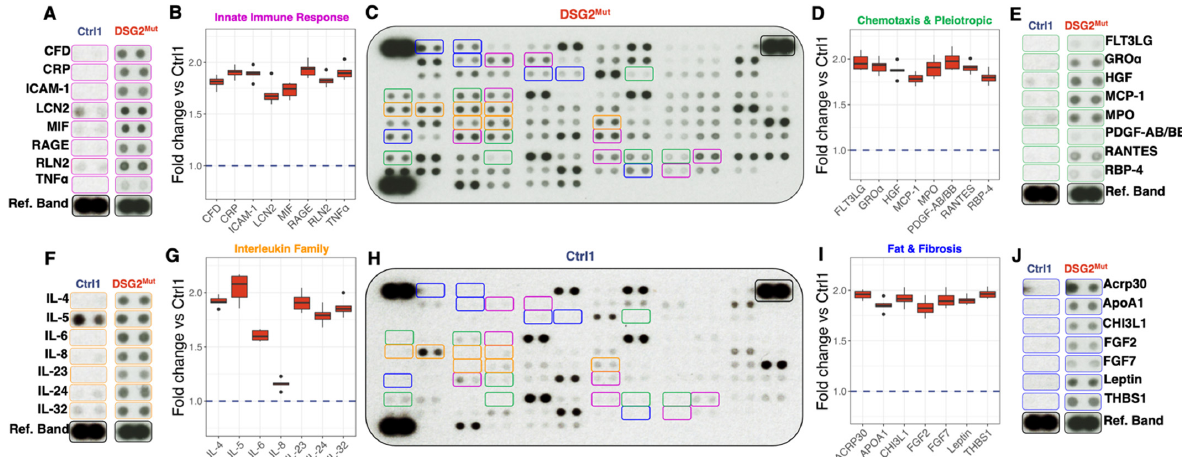
Figure 4. Cytokine expression in DSG2 Mut hiPSC-CMs. ( A , C , E , F , H , J ) Representative cytokine immunoblots from wildtype control (Ctrl1) and DSG2 Mut hiPSC-CMs, grouped based on their role in inflammation: ( A ) the innate immune response (purple); ( E ) chemoattractant and pleiotropic regulation (green); ( F ) interleukins that regulate immune cell differentiation and proliferation (orange); and ( J ) adipo-fibrokines involved in lipid accumulation and metabolism and fibrotic remodeling (blue). ( B,D,G,I ) Box and whisker plots of selected cytokines from Figure 4A,E,F, and J. Data presented as mean ± standard deviation.; Blue dashed line represents normalized values for Ctrl1; Ctrl1 ( n = 4); DSG2 Mut ( n = 6); For all values shown in (B,D,G,I) p < 0.05 comparing DSG2 Mut vs Ctrl1.